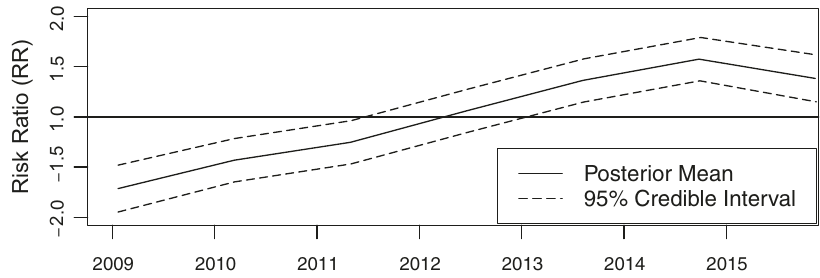
Fig. 2 Posterior mean temporal trend of the risk ratio from 2009 to 2015. The solid line shows the posterior mean risk ratio (RR) over the study period. The dashed lines show 95% credible intervals (CI) of RR.